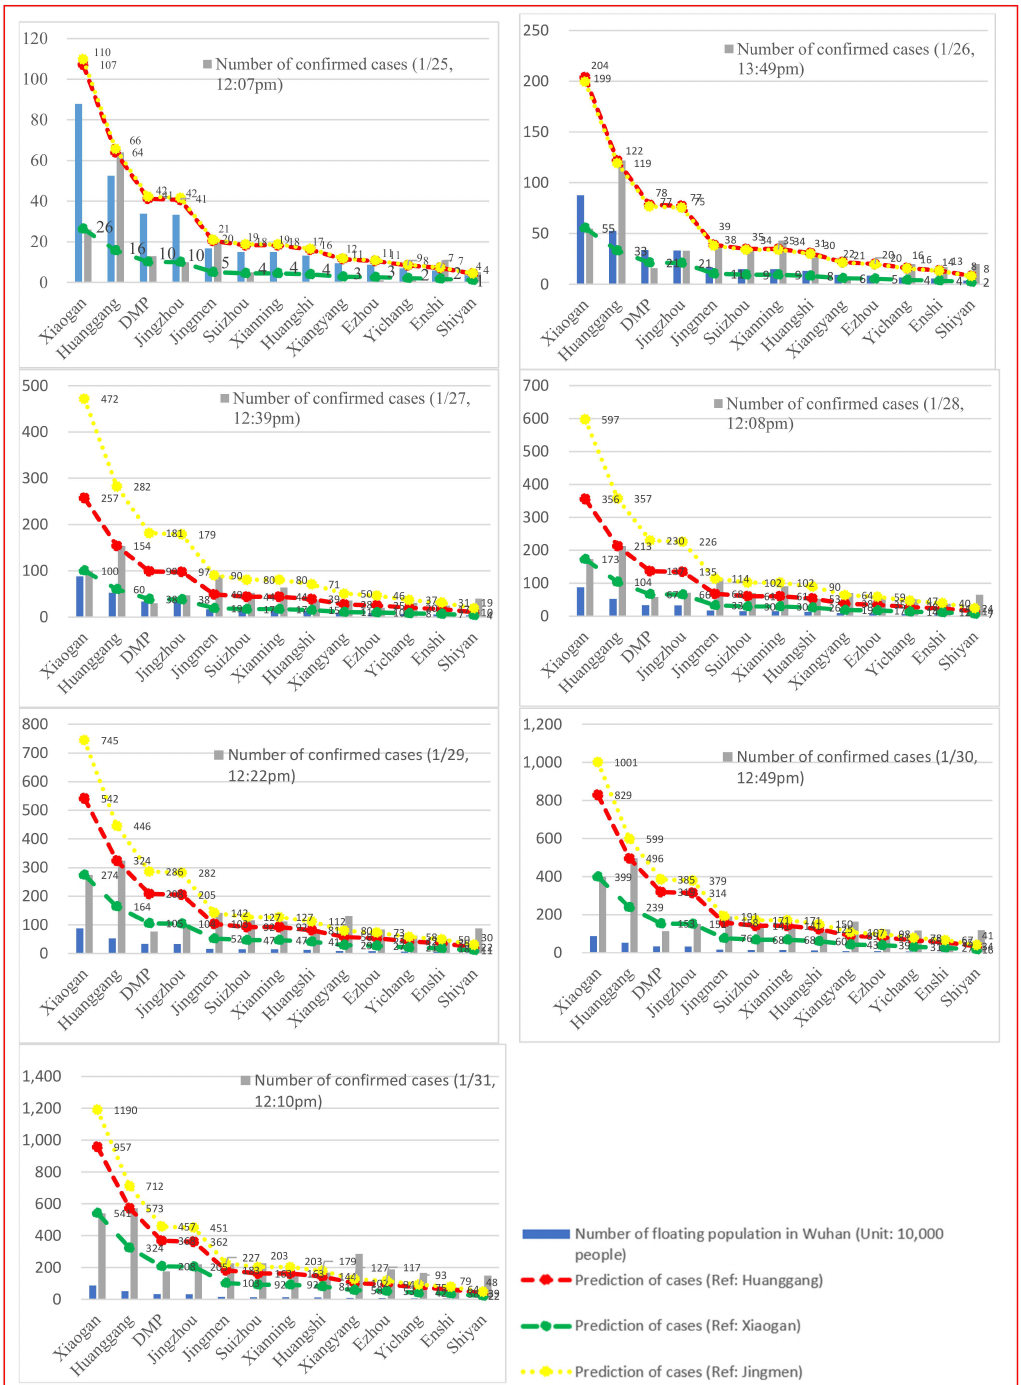
Figure 3. Prediction of the epidemic situation in Hubei